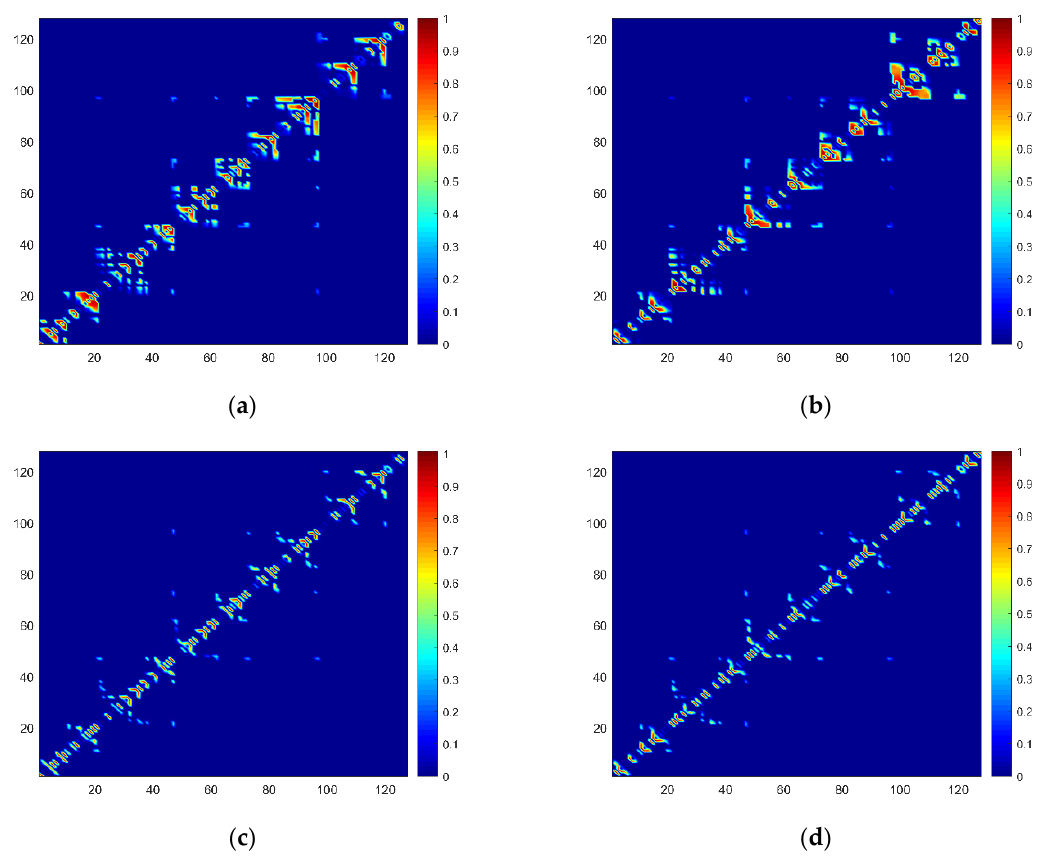
Figure 7. Visualization normalized weight matrices of forward and backward weighted complex networks. ( a ) FWVG; ( b ) BWVG; ( c ) FWHVG; ( d ) BWHVG.